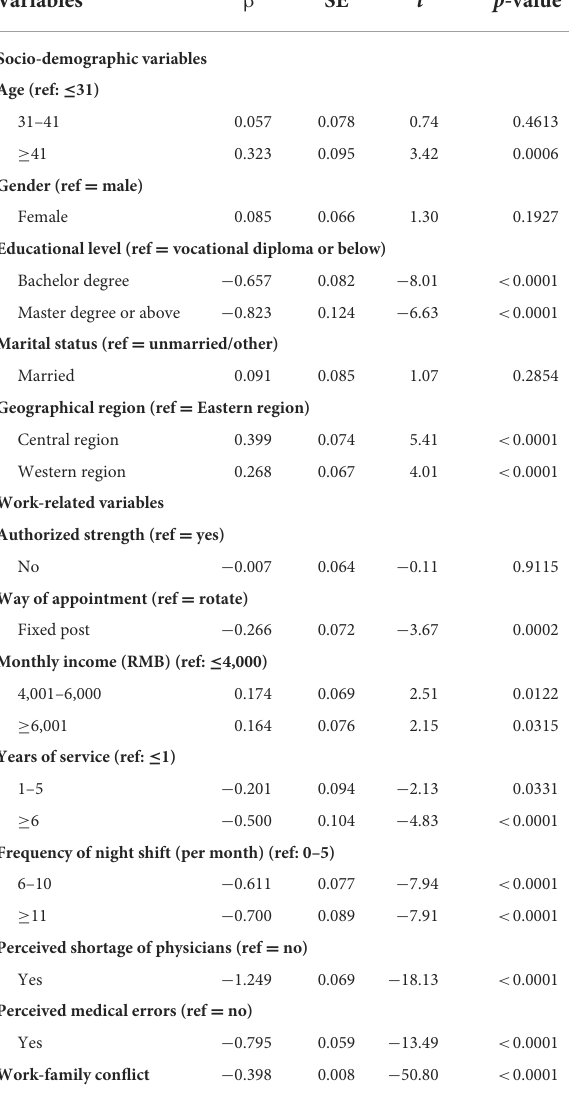
TABLE 2 Generalized linear regression examining factors associated with job